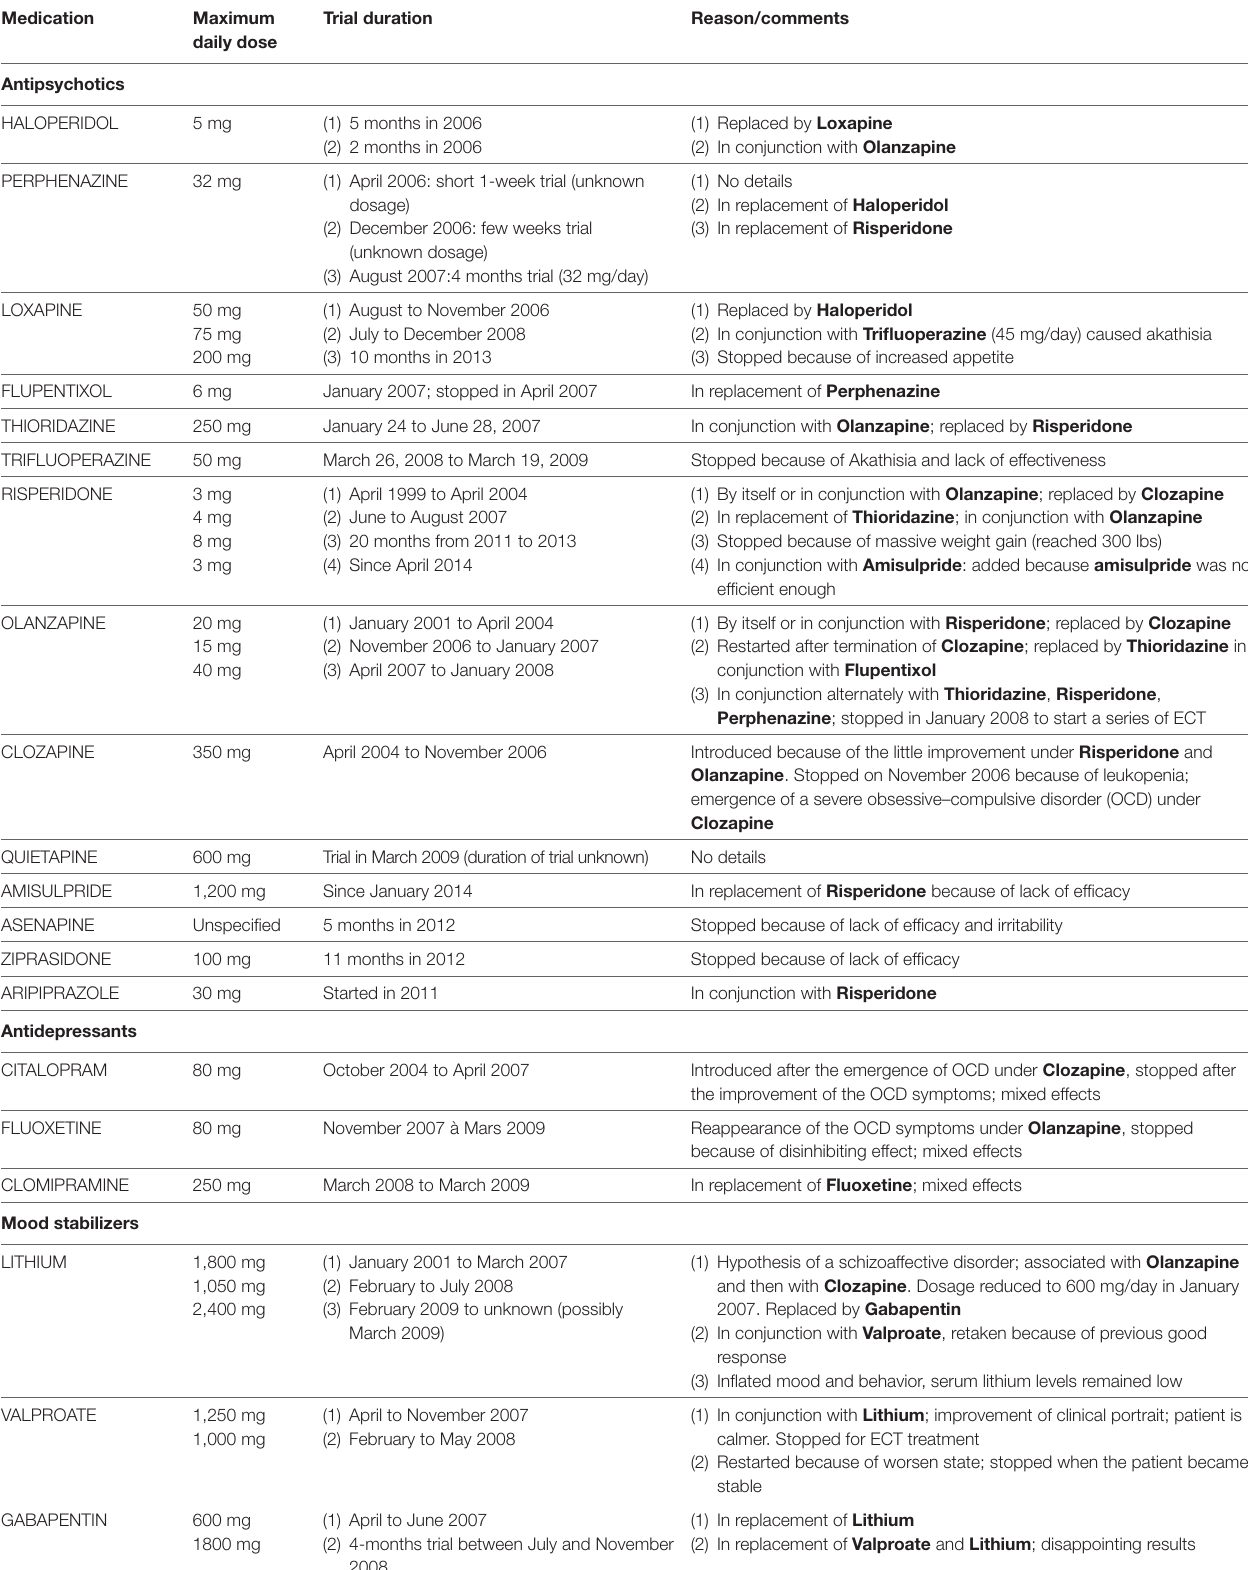
tabLe 1 | Pharmacological